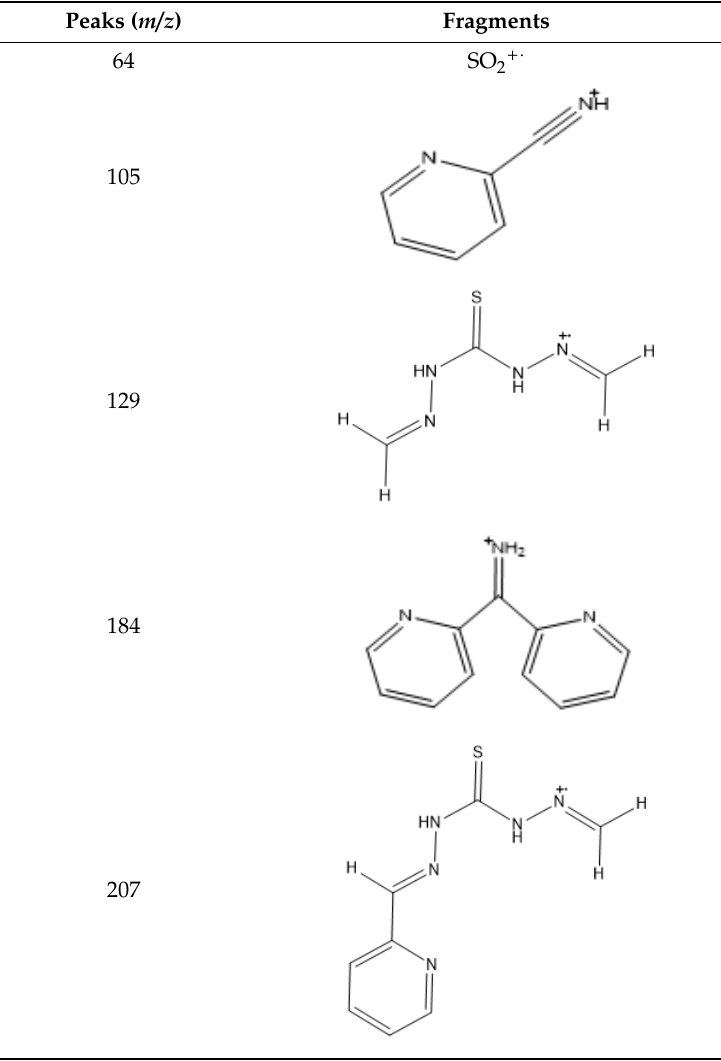
Table 3. MS spectra assignment of peaks.